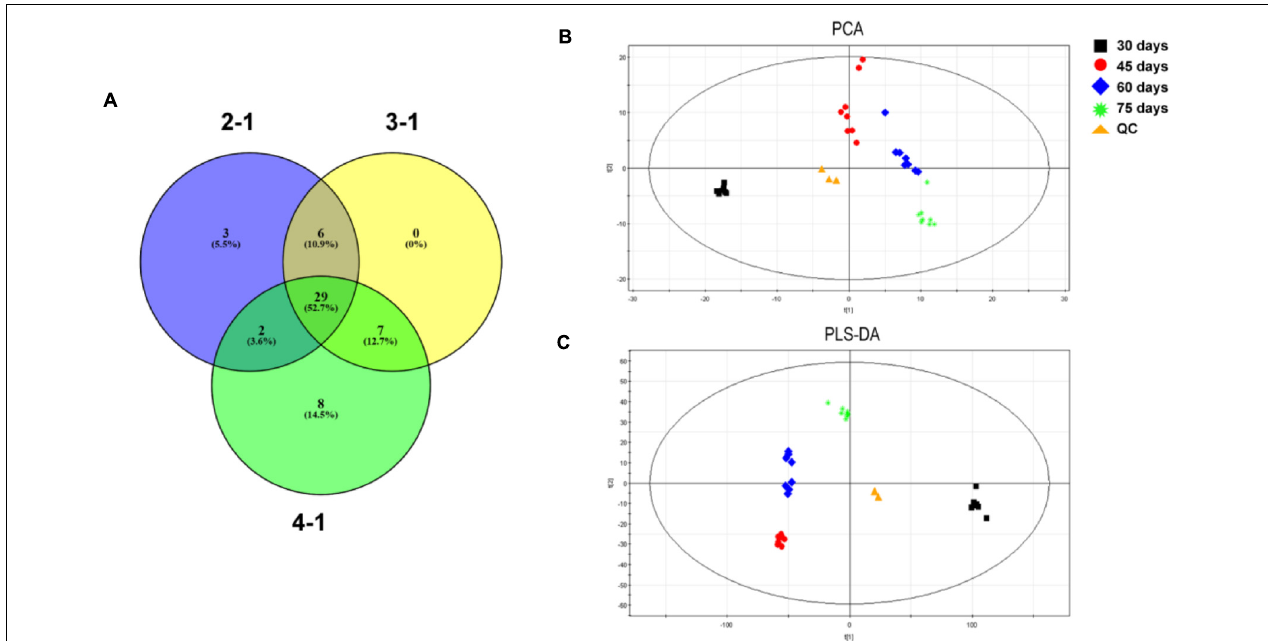
FIGURE 5 | (A) Venn diagram of significantly changed metabolites in four experimental groups in brown film (BF) formation in Lentinula edodes . Comparisons: 2-1, 45 days vs. 30 days; 3-1, 60 days vs. 30 days; and 4-1, 75 days vs. 30 days. (B) Principal component analysis (PCA) and (C) partial least squares discriminant analysis (PLS-DA) score plots of metabolic profiles during BF